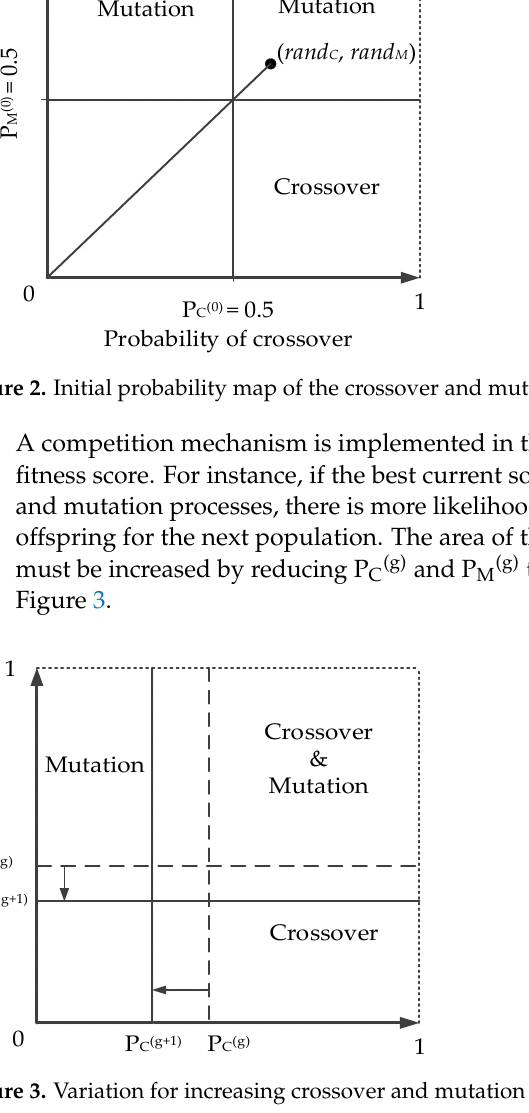
Figure 3. Variation for increasing crossover and mutation probability.